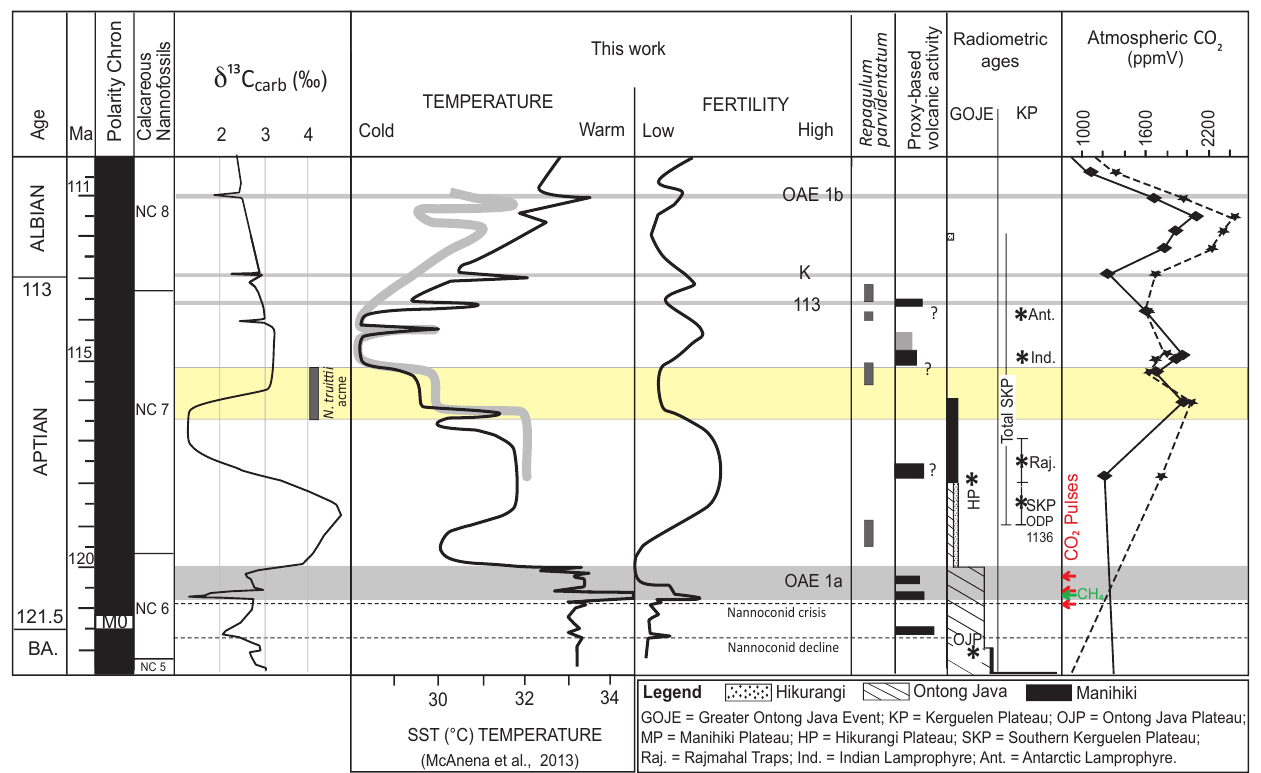
Figure 7. Nannofossil-based temperature and nutrient variations reconstructed from the three-point moving averages of the TI and NI in the three studied sections (as in Fig. 6). The thick-grey curve represents SSTs from McAnena et al. (2013). Bio-chemo-magneto stratigraphy after Erba et al. (2015). Numerical ages are based on the timescale of Malinverno et al. (2012). Multiproxy-based volcanic phases and radiometric ages of the Greater Ontong Java Event (GOJE) and Kerguelen Plateau (KP) LIPs are from Erba et al. (2015). Atmospheric CO 2 : Li et al. (2014) reporting estimates based on highly smoothed average δ 13 C r (diamonds) and on isotopic data from Tethyan pelagic sediments (stars). The volcanogenic CO 2 (red arrows) and CH 4 (green arrow) pulses are from Méhay et al. (2009) and Erba et al.